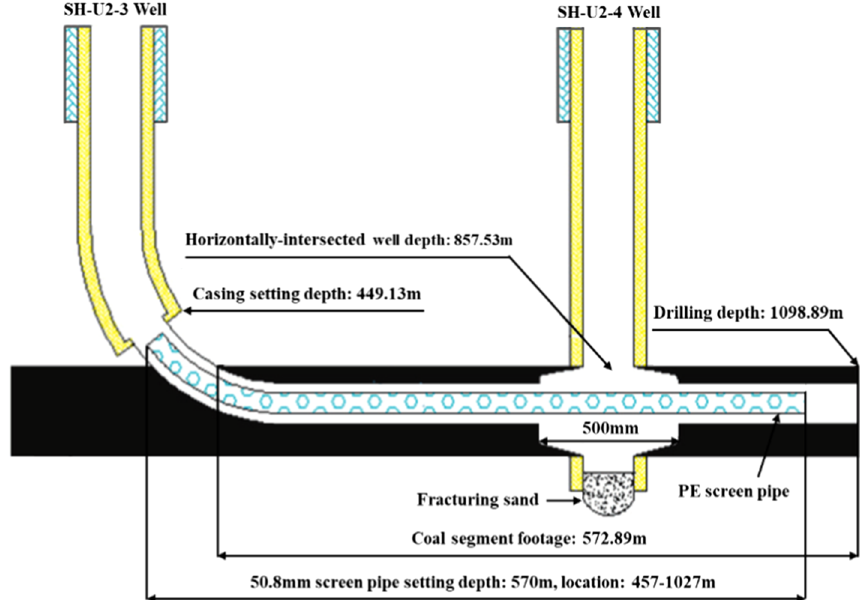
Fig. 29 Schematic of PE screen pipe completion, modified from Zhao et al. (2014)